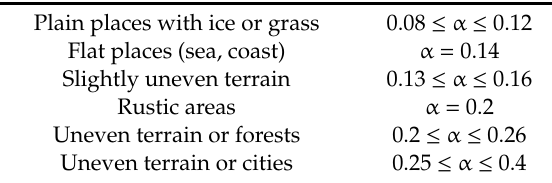
Table 1. Friction coe ffi